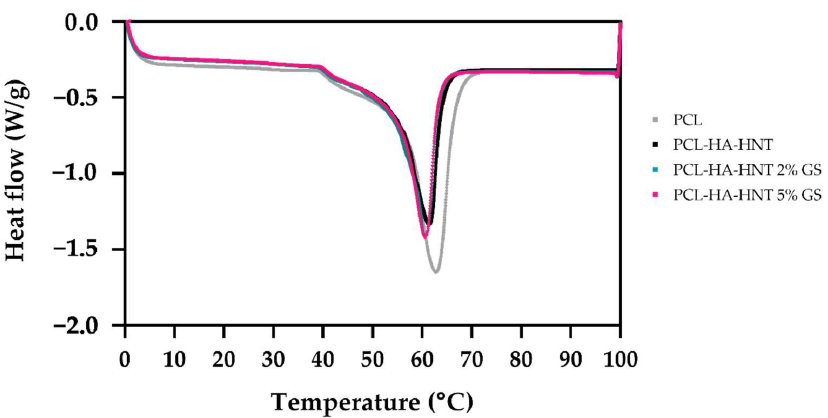
Figure 4. DSC analysis of produced PCL, PCL-HA-HNT and GS loaded PCL-HA-HNT at 2% and 5% filaments.